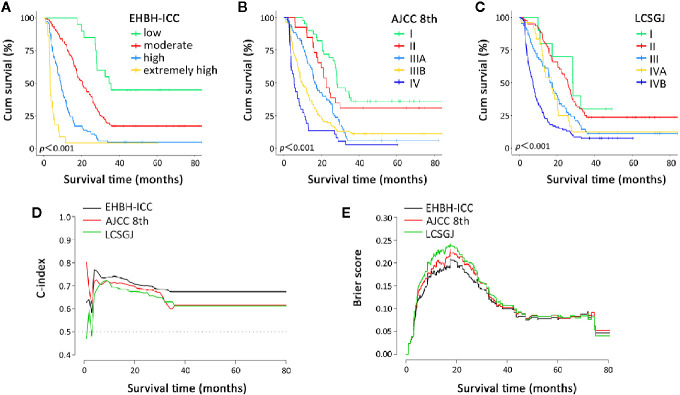
Overall survival curves and prognostic performance indicator curves in the Eastern Hepatobiliary Surgery Hospital-intrahepatic cholangiocarcinoma (EHBH-ICC), American Joint Committee on Cancer (AJCC) 8th, and the Liver Cancer Study Group of Japan (LCSGJ) staging systems. (A–C) depict the overall survival according to the three staging systems in internal validation cohort, all log rank p<0.001. (D, E) present the C-index and brier score change in long-term survival, respectively.